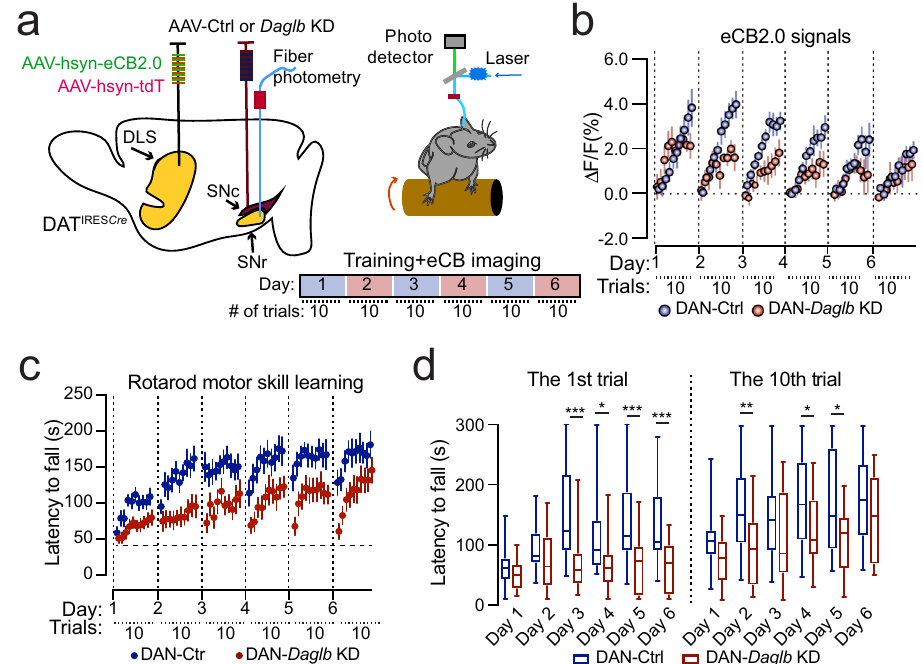
Fig. 5 Daglb -de fi ciency in nigral DANs compromises the early dynamic release of 2-AG and impairs rotarod locomotor skill learning. a Schematic diagram of eCB2.0 fi ber photometry recoding while DAN-Ctrl or DAN- Daglb KD mice undergo rotarod locomotor skill training. b Normalized eCB2.0 signal intensity over the course of locomotor learning of DAN-control and DAN- Daglb KD ( n = 5 M per genotype) mice. Data were presented as mean ± SEM. Two-way ANOVA, genotype: F (1, 8) = 13. 68, p = 0.006. c Rotarod locomotor skill training of a different cohort of DAN-control ( n = 16, 8M/8F) and DAN- Daglb KD ( n = 16, 8M/8F) mice. Data were presented as mean ± SEM. Two-way ANOVA, genotype: F (1, 30) = 9.3, p = 0.0047. d Box and whiskers plot (the minimum, the 25th percentile, the median, the 75th percentile, and the maximum) of rotarod performance in the fi rst and 10th trial on each day with the same cohorts of DAN-control ( n = 16, 8 M/8F) and DAN- Daglb KD ( n = 16, 8M/8F) mice. Multiple unpaired t test, two-tailed, * p < 0.05, ** p < 0.005, *** p < Daglb KD mice [two-way ANOVA, treatment: F (1, 21) = 59.9,